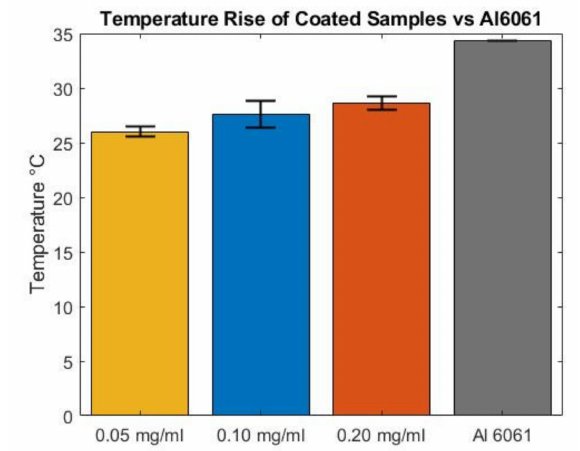
Figure 8. Surface thermal dissipation performance as a function of the MWCNTs’ concentration solutions. Thermal dissipation performance improves 31%, 24% and 19% for Al6061 samples coated with MWCNTs concentration solutions of 0.05, 0.10 and 0.20 mg / mL,